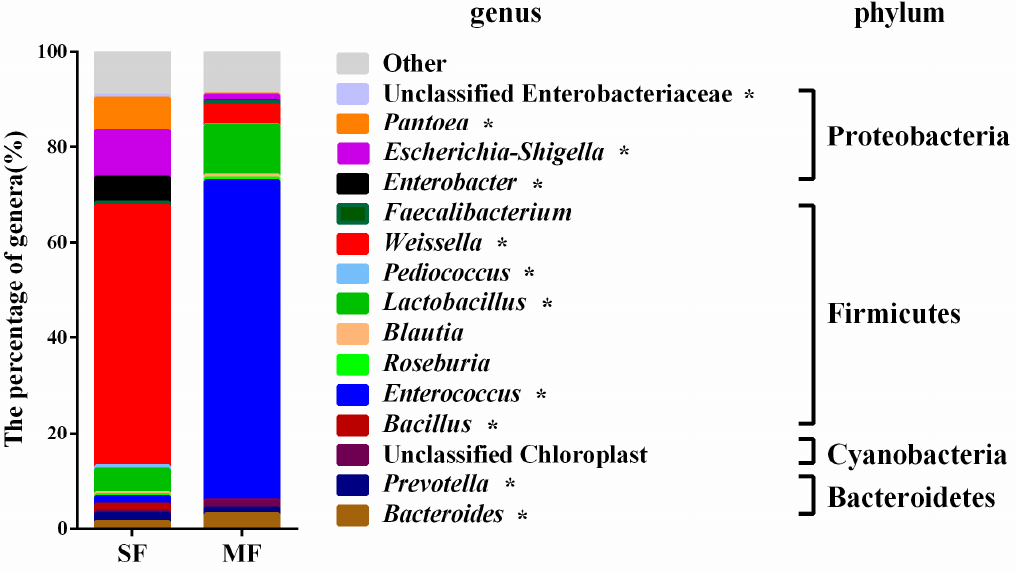
Figure 2. Phylum-level taxonomic composition of the bacterial communities in fermented feed samples.